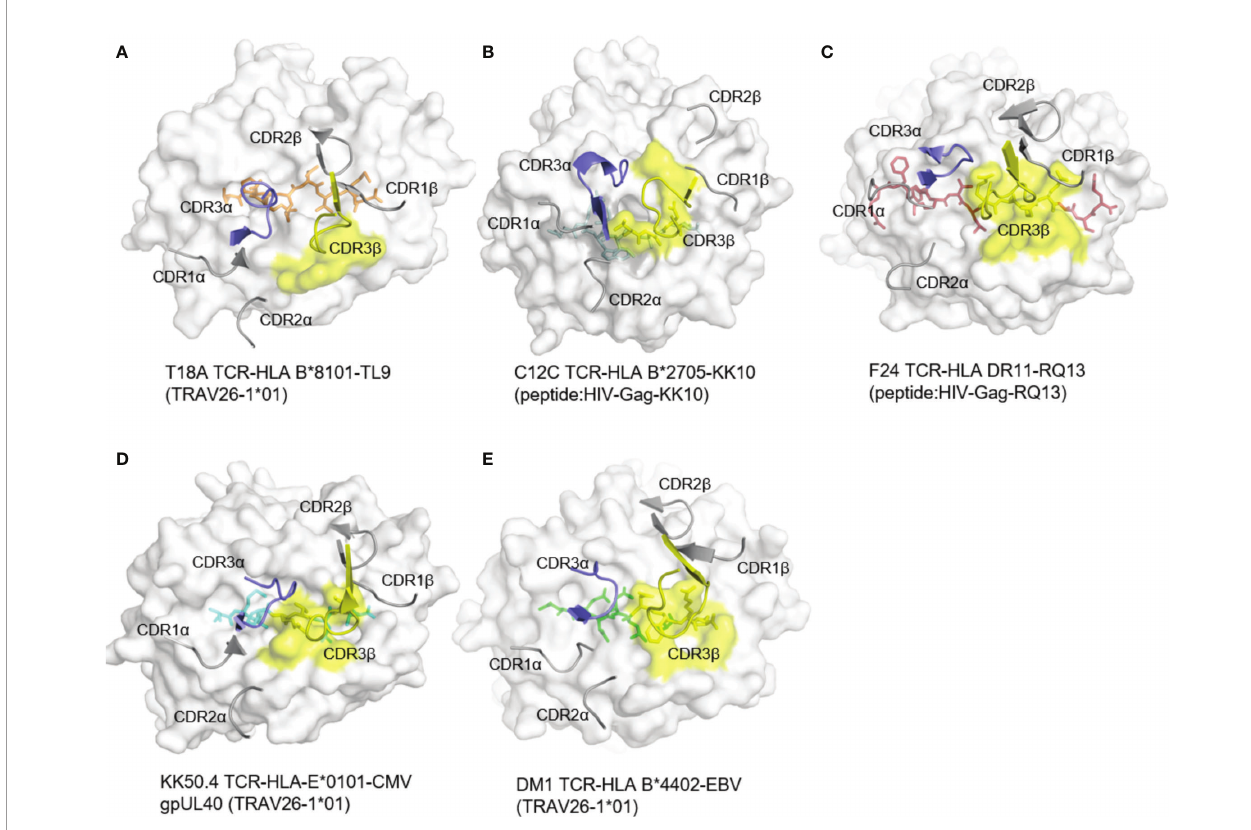
FIGURE 3 | The rare docking mode of T18A CDR3 b on a 2 helix of the HLA but not the peptide. The foot print of TCR CDR3 b on p-MHC complexes are colored in yellow from 5 different recognition pro fi les. (A) The foot print of T18A TCR CDR3 b on p-HLA complex. (B – E) CDR3 b use in other 4 structures, C12C TCR (PDB: 4G8G), F24 TCR (PDB: 6CQL), KK50.4 TCR (PDB: 2ESV) and DM1 TCR (PDB: 3DXA). Peptide in each panel is shown in stick, CDR loops are shown in cartoon, and MHCs are shown in surface